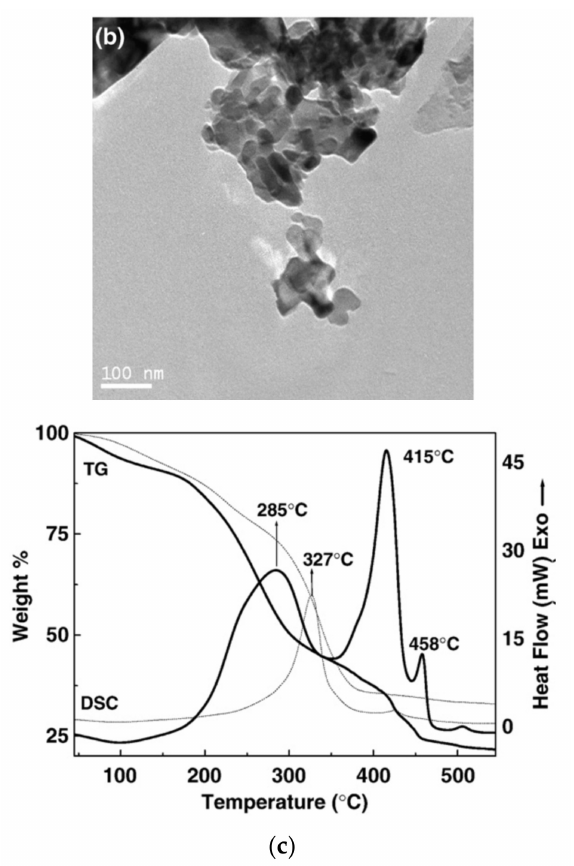
Figure 6. ( a , b )TEM images of α -Fe 2 O 3 nanoparticles calcinated at 450 ◦ C, ( c ) thermogravimetric analysis of precursors in air. Obtained permission from Ref. [59]. Copyright 2009